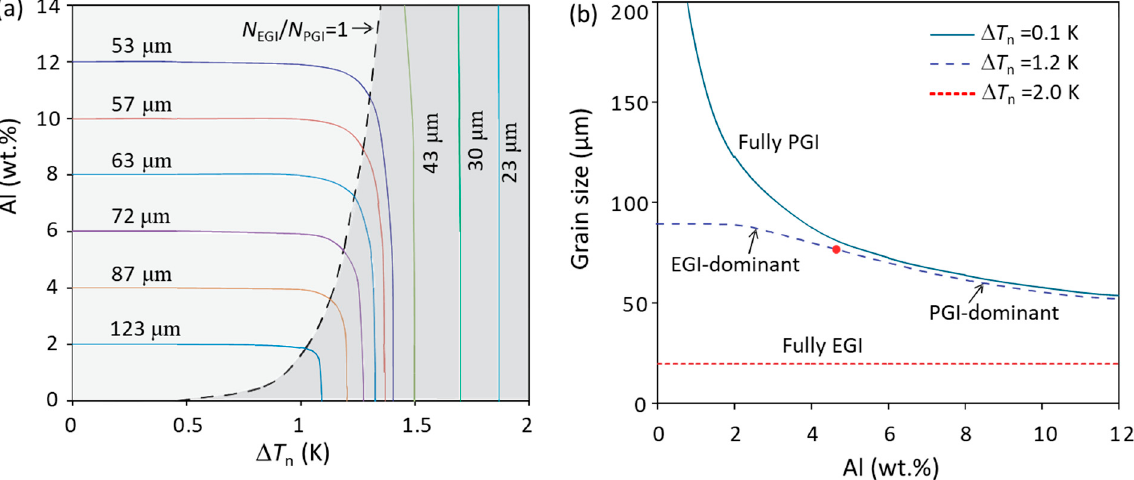
Figure 8. ( a ) Grain refinement map of the ∆ T n - C 0 (nucleation undercooling-composition) plot and ( b ) solute effect on grain size for Mg-Al alloys with particle number density 10 17 m − 3 and a log-normal size distribution ( d 0 = 0.67 μ m and σ = 0.876) at Ṫ = 3.5 K/s [20].